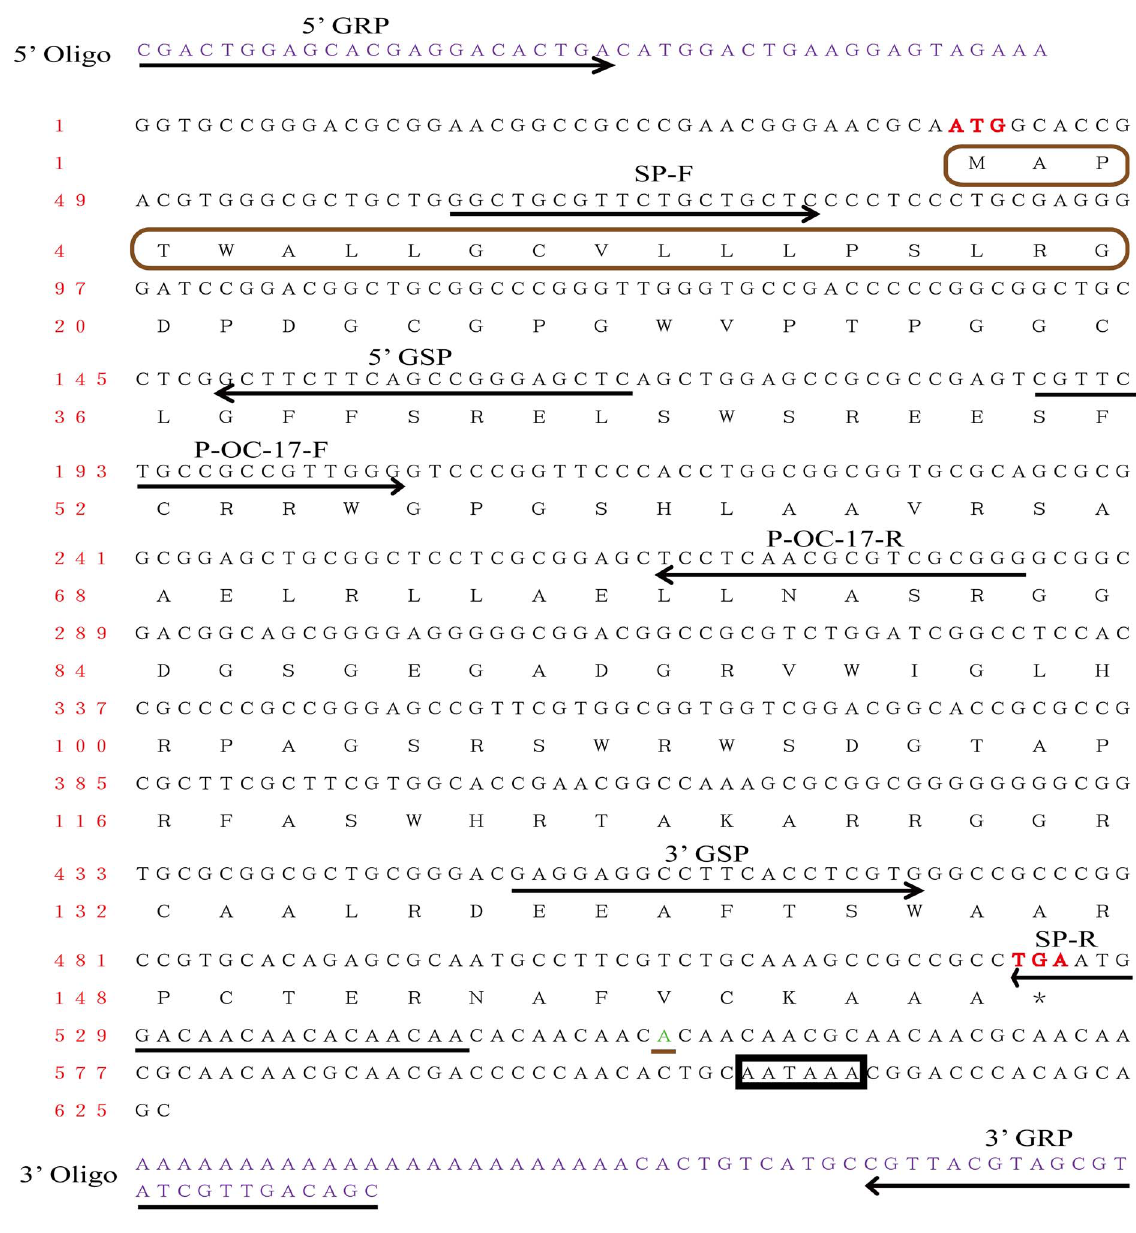
Figure 2. RACE strategies for cloning Ovocleidin-17 and nucleotide and deduced amino acid sequence of OC-17. The protocol of the SuperScriptTMIII RT Kit (Invitrogen Life Technologies Bio Inc.) was followed. Gene RACE Primers (GRP) anneal to the adaptor sequence, and Gene Special Primers (GSP) were designed to be complementary to the Ovocleidin-17 cDNA. The start and stop codons of the open reading frame are marked in red color. Black box indicates the poly-adenylation signal (AATAAA). The nucleotides marked with red color were obtained by RACE. Brown box represented the extra 19 deduced amino acids compared with published OC-17 amino acids (Q9PRS8), which is a putative signal peptide. Note that there is a one nucleotide difference (green color with black underline) between the RACE cDNA and the assembled transcript.